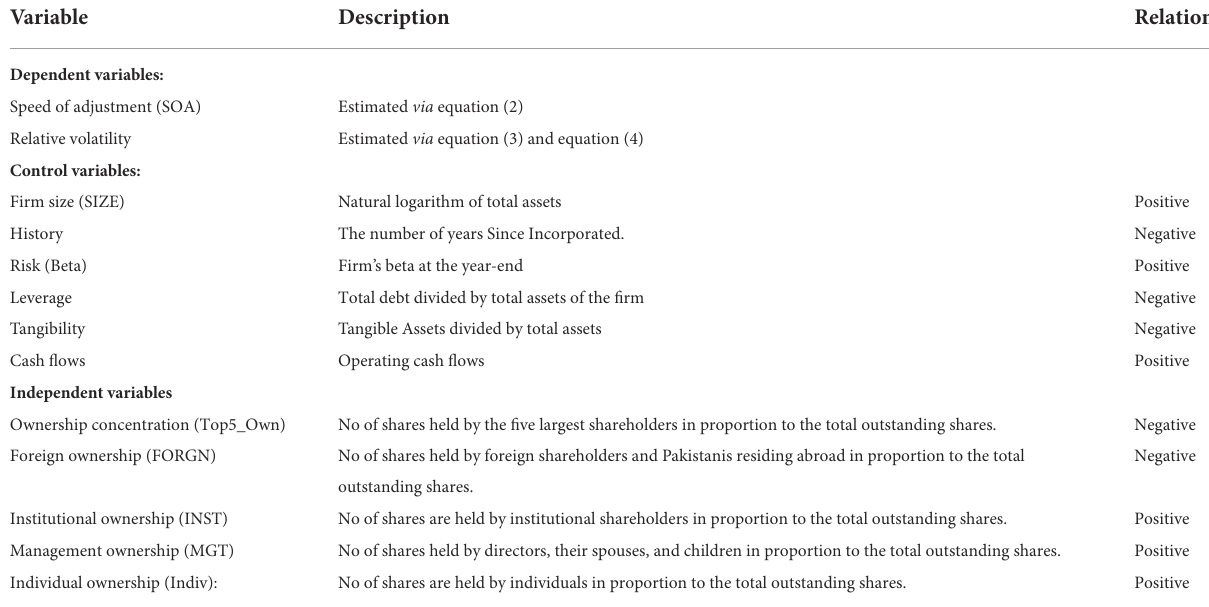
TABLE 1 Variables description.